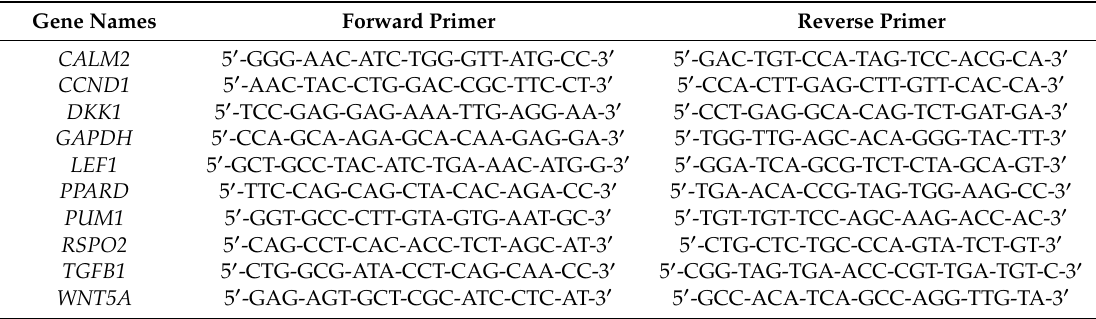
Table 3. List of designed primers sequences used for qRT-PCR